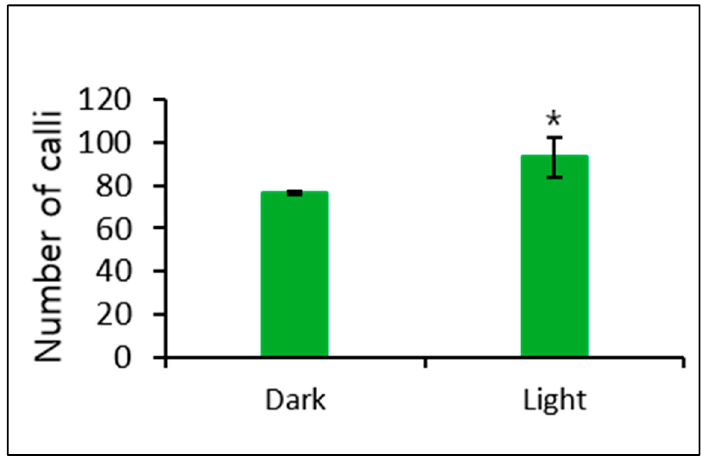
Figure 6. Effect of dark and light (16-h photoperiod) conditions on callus formation from microcalli cultured in Kao and Michayluk medium. Data represent the means of three replications. The bar indicates the standard deviation of three replications. Mean with asterisk (*) is significantly different by the t -test ( p < 0.05).